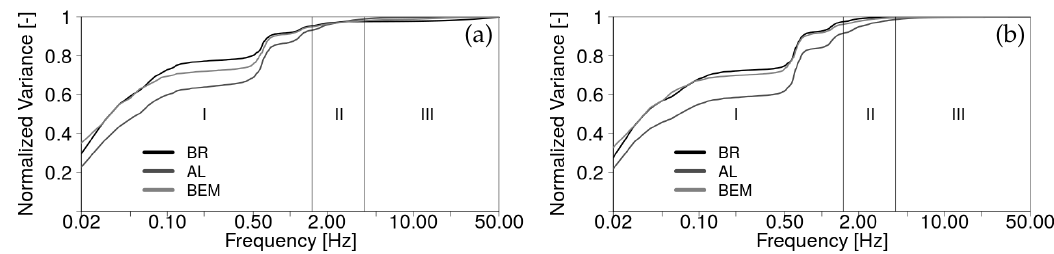
Figure 17. Normalized cumulative frequency dependent variance of ( a ) thrust and ( b )